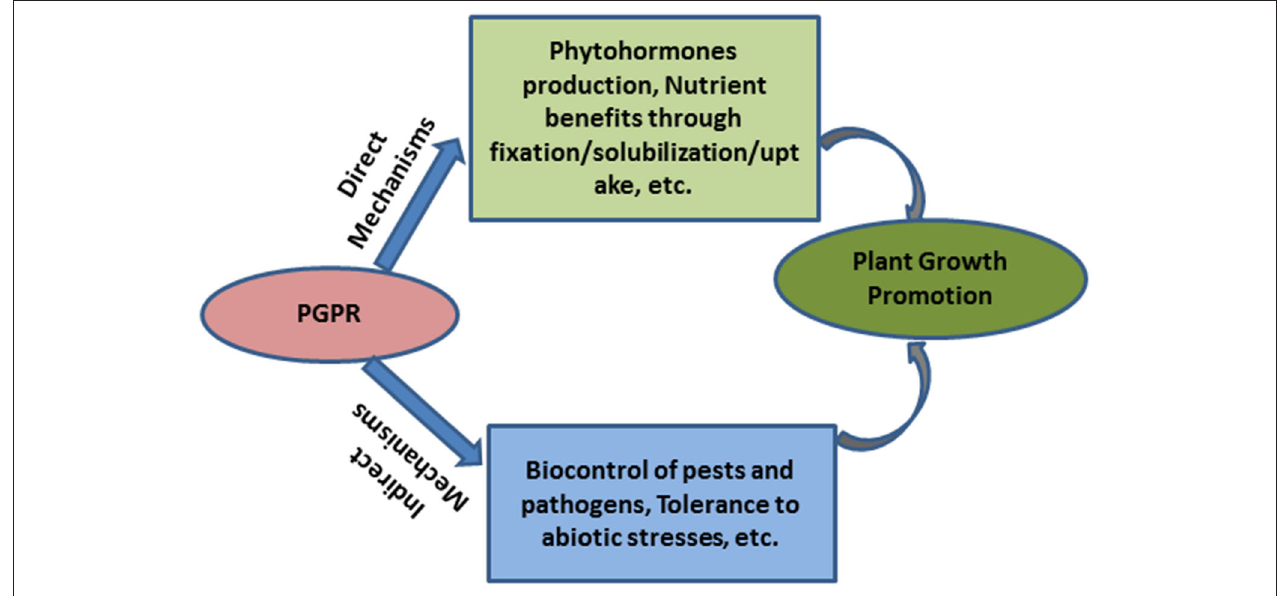
FIGURE 1 | Mechanisms of plant growth promotion by